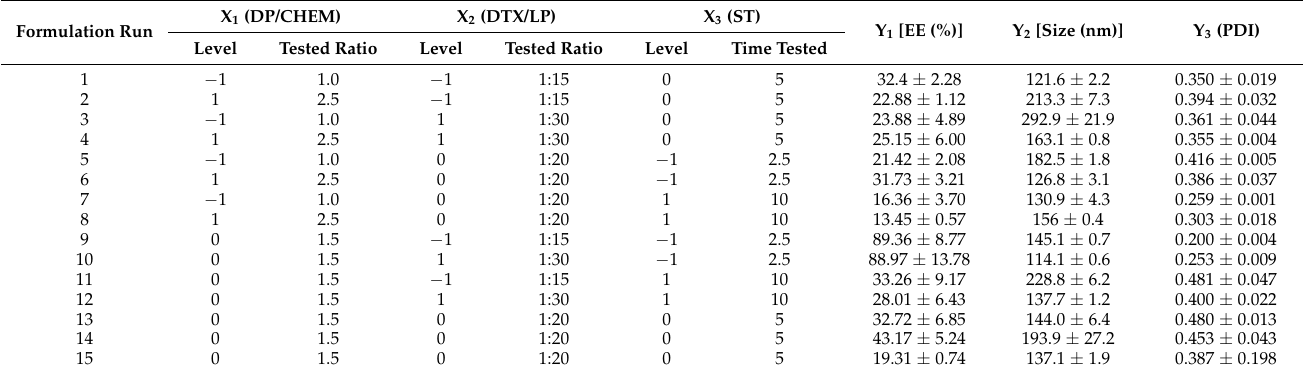
Table 2. Box–Behnken design representing experimental runs with independent variables at three levels ( − 1, 0, 1) and observed responses (EE%, Size and